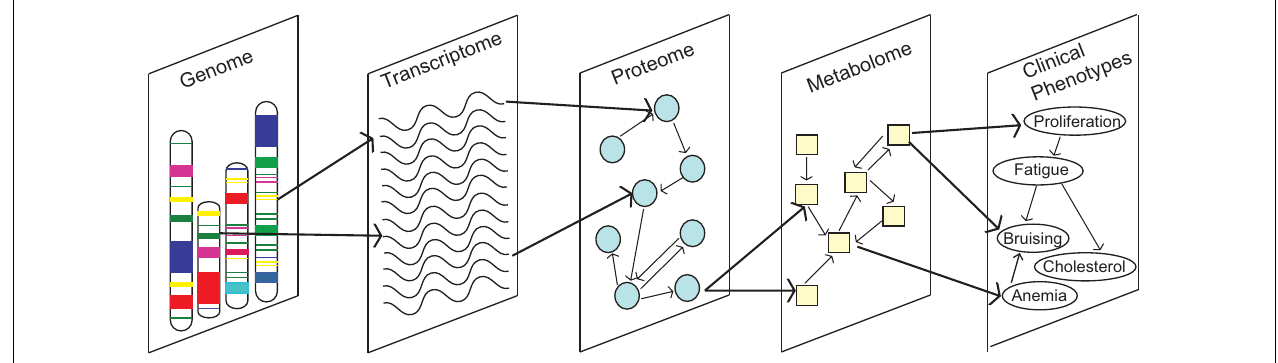
FIGURE 3 | Understanding how molecular traits from different biological domains connect in networks is critical to progressing Cancer Biology.